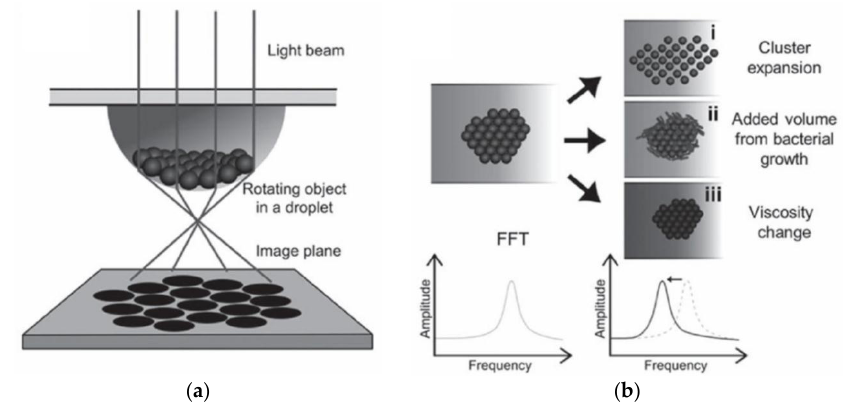
Figure 12. Sketch of the bead assembly magnetorotation detection principle. ( a ) At the bottom of a hanging droplet, a cluster of magnetic particles forms, and the response of the cluster to an applied rotating magnetic field is observed optically in the imaging plane; ( b ) Changes in cluster assembly (particle density or total cluster volume) or variations in local fluid viscosity lead to an altered rotation frequency of the cluster, which is analyzed from the optical signal by fast Fourier transformation (FFT). Reprinted with permission from [235]. Copyright 2012, John Wiley and Sons.